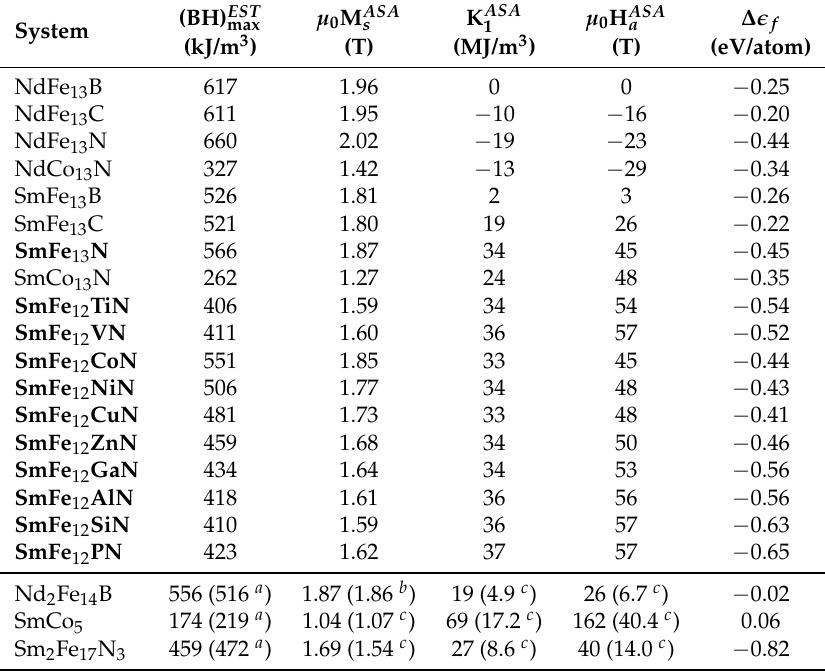
Table 2. Selection of screening results. Key quantities calculated with tight-binding linear-muffin-tin-orbital atomic-sphere approximation (TB-LMTO-ASA) are listed: the maximum energy product ( BH ) EST max , the spontaneous magnetization M ASA s , the anisotropy constant K ASA , and the anisotropy field H ASA a . The last 1 column lists the formation energies ∆ (cid:101) f at T = 0 K with respect to the elemental constituents (cf. discussion in Section 2.3). For comparison, the table includes the theoretical results for Nd 2 Fe 14 B and SmCo 5 as the two benchmark compounds with the highest experimental values for maximum energy product ( BH ) max and anisotropy field H a . Furthermore, Sm 2 Fe 17 N 3 is given, which consists of Sm, Fe, and N just like SmFe 13 N, the screening result with the highest value of ( BH ) EST max . Experimental data taken from a Ref. [41], b Ref. [42], and c Ref. [43] (Table 11.1 therein) are given in brackets. The experimental M s values are determined at 4 K, whereas K 1 and H a are room-temperature values. The most promising candidates for new hard-magnetic phases obtained from the HTS are highlighted in bold letters. Our selection criteria are ( BH ) EST max ≥ 400 kJ/m 3 and K ASA 1